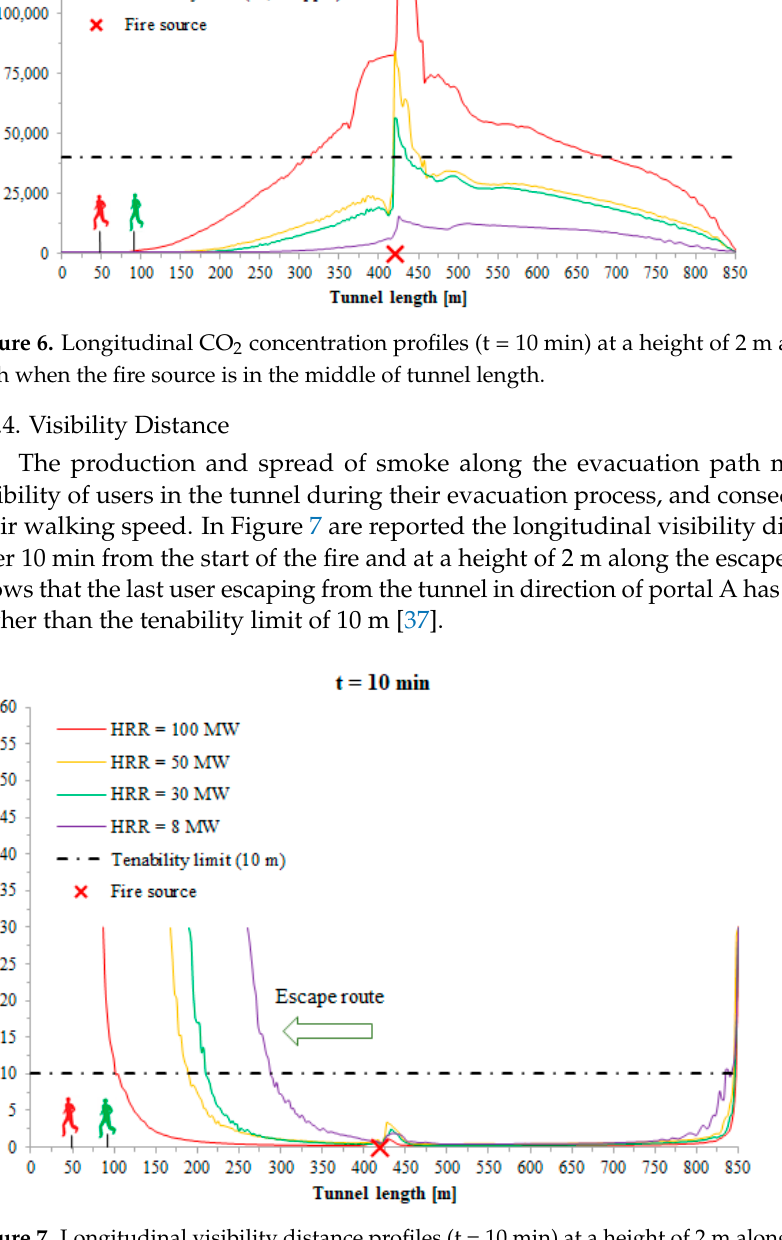
Figure 5. Longitudinal CO concentration profiles (t = 10 min) at a height of 2 along the escape path when the fire source is in the middle of the tunnel length.